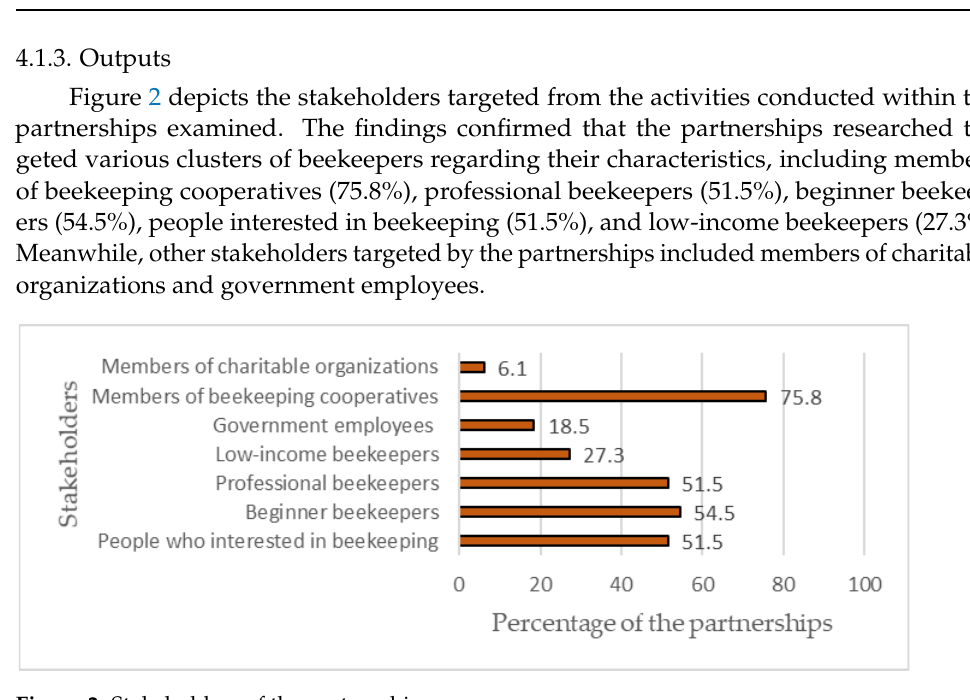
Figure 2. Stakeholders of the